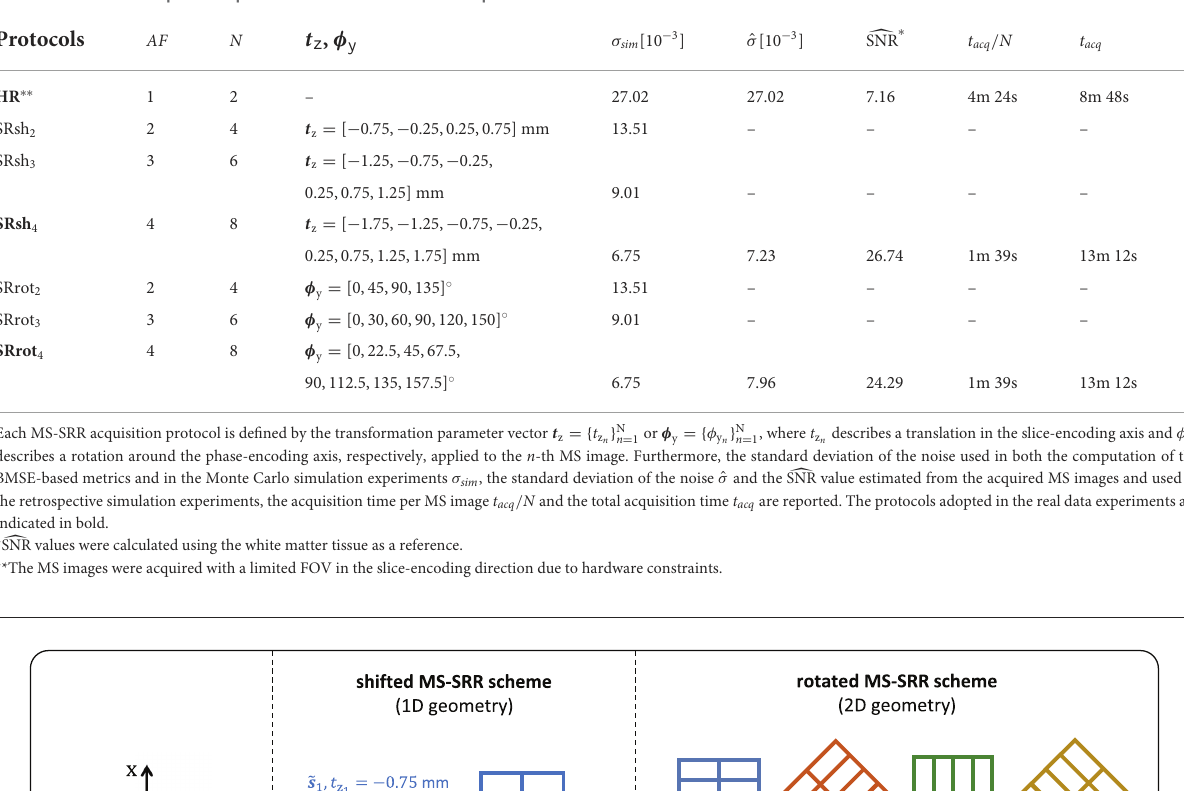
2, N 4, and res ip 1 mm. = = =